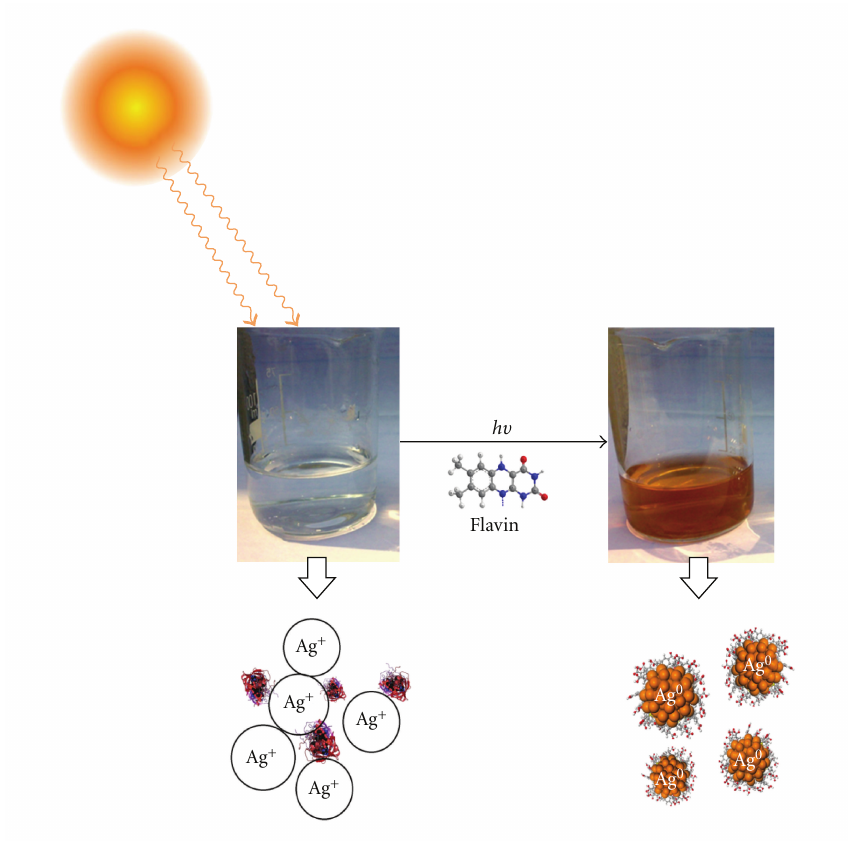
Figure 8: Probable pathway of synthesis